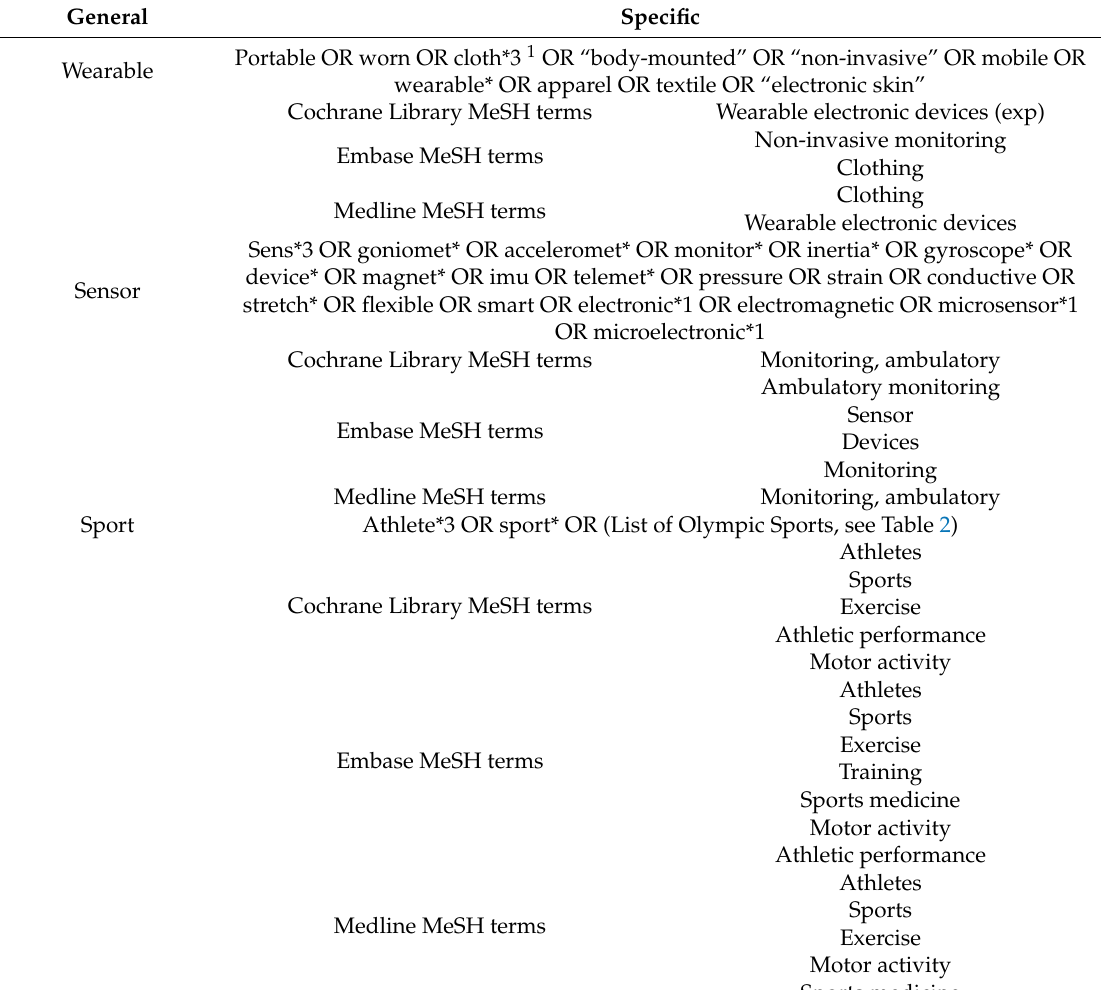
Table 1. Boolean search strategy.